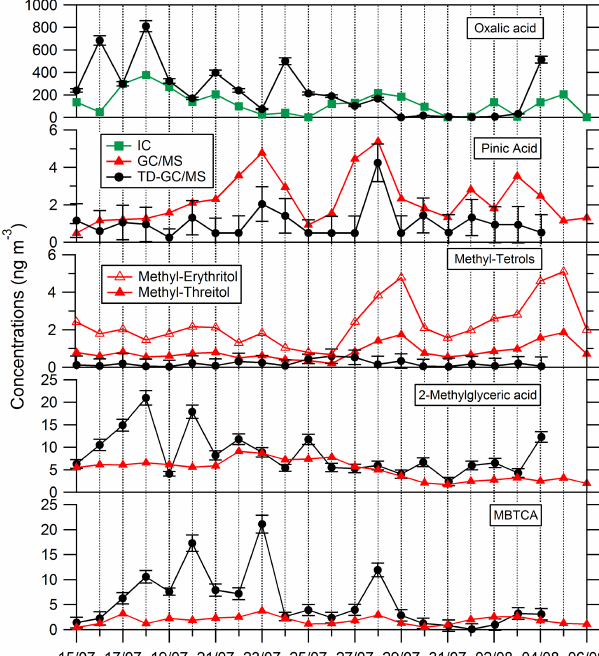
Figure 7. Comparison of ATD–GC–MS data with ion chromatog- raphy and GC–MS analysis for particulate oxalic acid, pinic acid, methyl tetrols, 2-methylglyceric acid and MBTCA (3-Methyl-1,2,3- tricarboxylic acid). Error bars correspond to the 1 σ uncertainties in TD–GC–MS